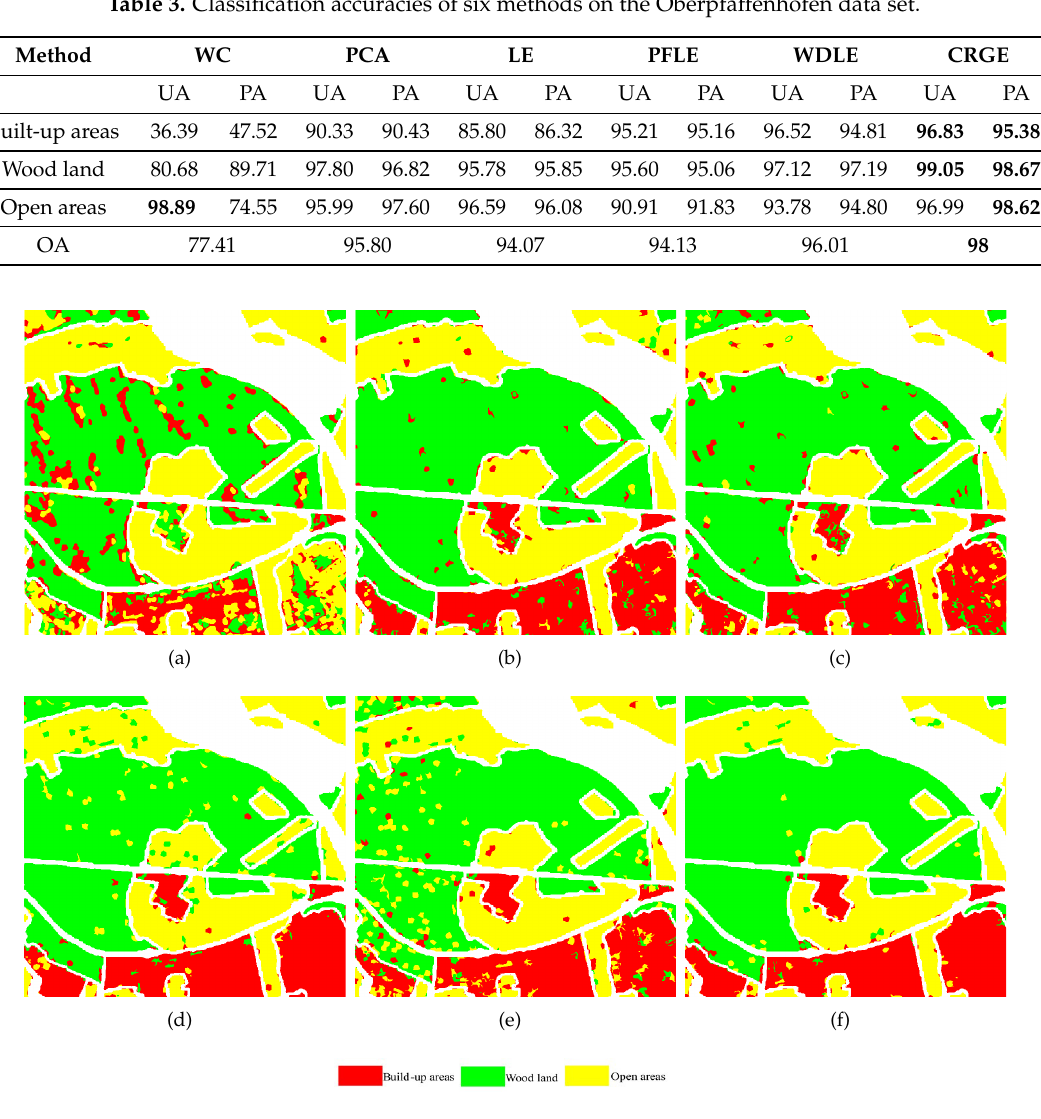
Figure 10. Visual classification results on the Oberpfaffenhofen data set. ( a ) the Wishart classifier, ( b ) PCA, ( c ) LE ( d ) PFLE, ( e ) WDLE and ( f ) the proposed